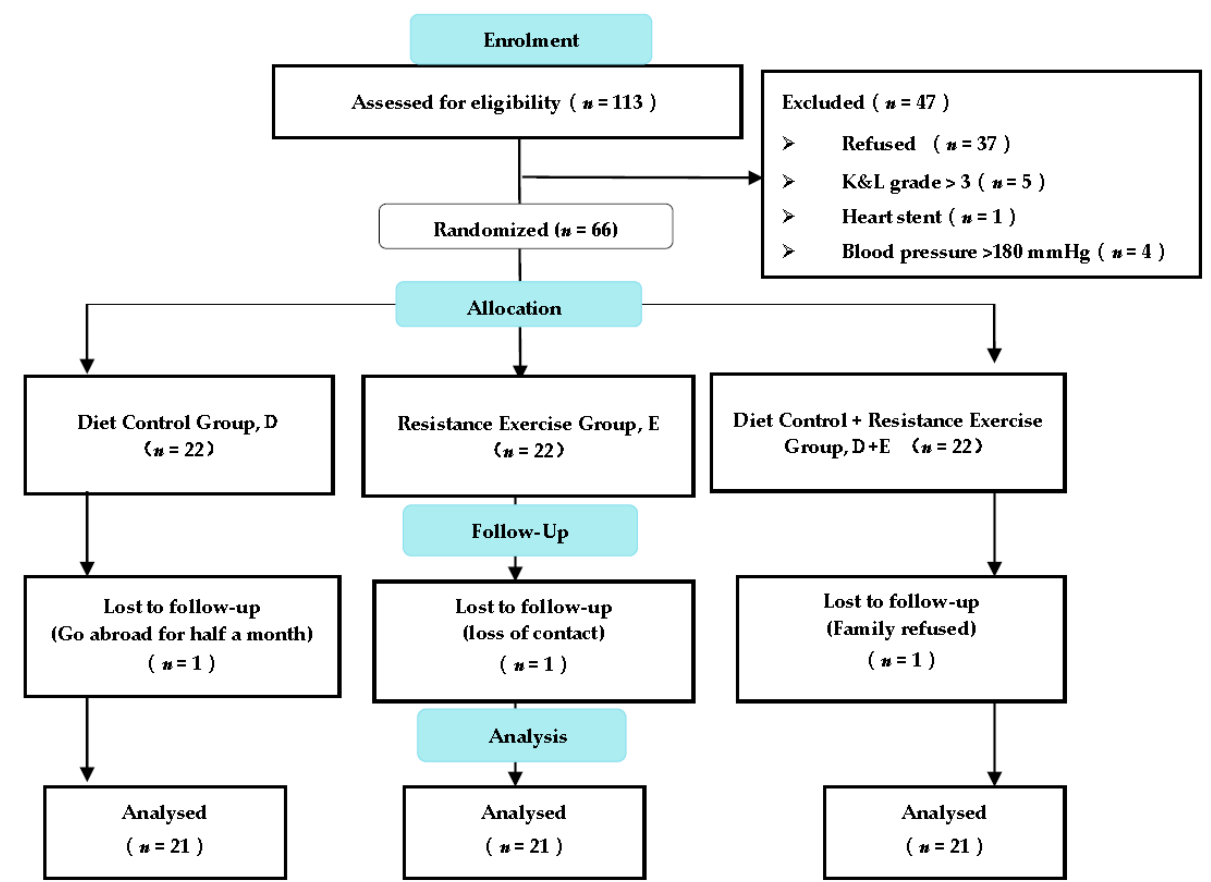
Figure 2. Consolidated Standards of Reporting Trials flow diagram. Table 1. Baseline characteristics of participants.